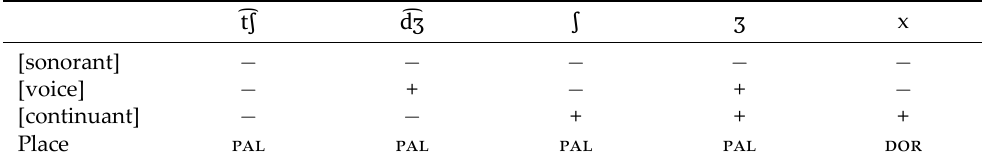
Table 4. Phonological features that define five obstruent